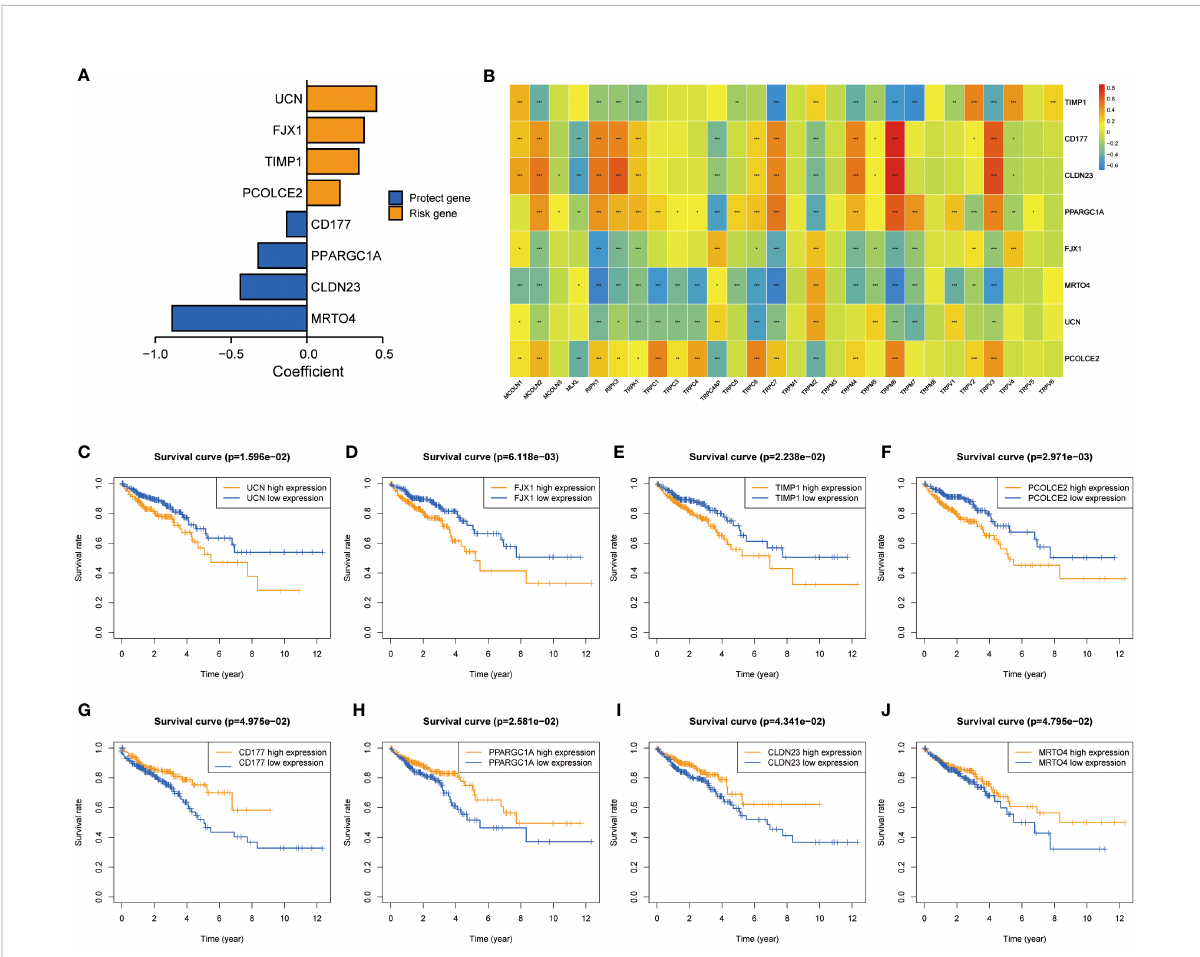
FIGURE 3 Screening of characteristic predictors and prognostic value of TRPCRS. (A) The coef fi cient value of the 8 TRPCGs associated with the TRPC score in CRC. (B) The correlation between 8 TRPCGs and 28 TRPCR. (C-J) Survival curve analysis of CRC patients based on the expression status of UCN, FJX1, TIMP1, PCOLCE2, CD177, PPARGC1A, CLDN23, MRTO4 genes. CRC, colorectal cancer; TRPCGs, transient receptor potential channels-related genes; TRPCR, transient receptor potential channels regulators; TRPCRS, transient receptor potential channels related signature; ns, not signi fi cant; *P< 0.05; **P< 0.01; ***P<